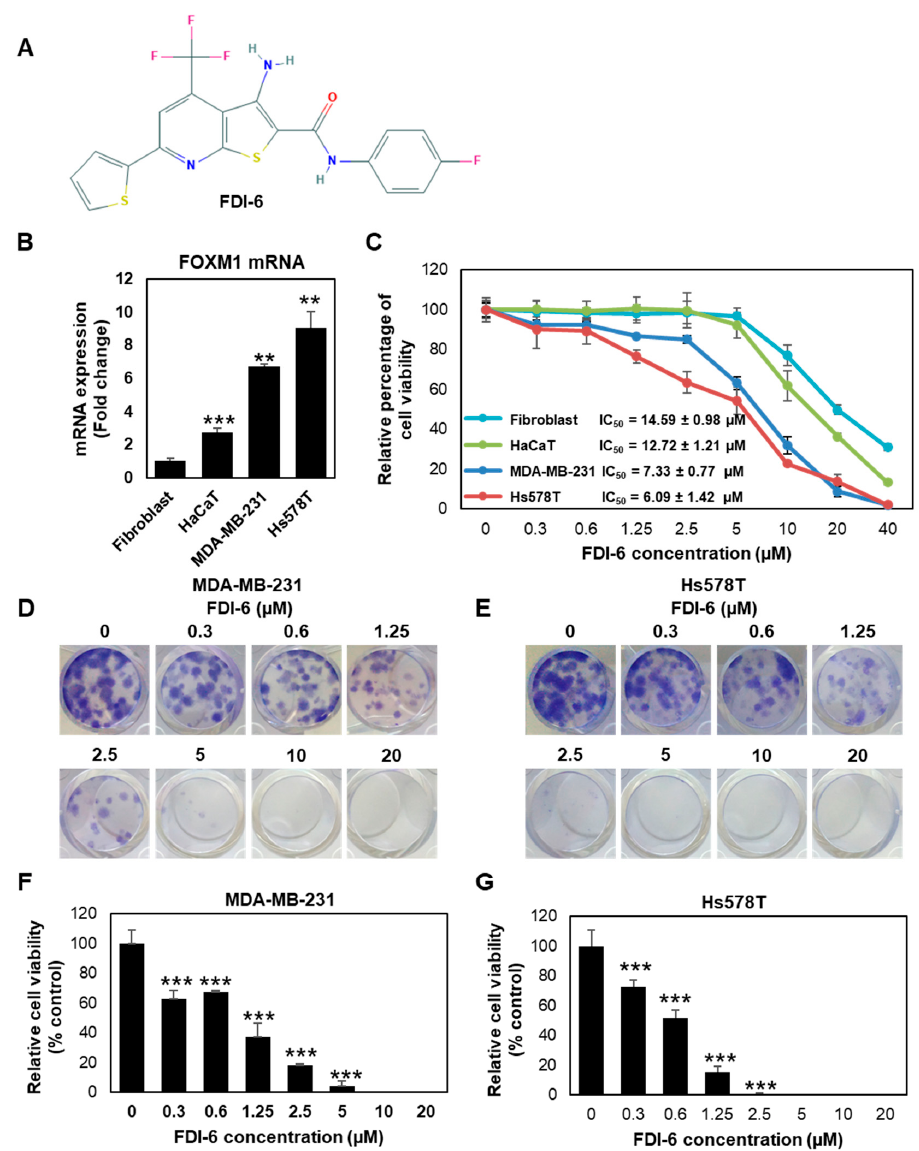
Figure 1. FDI-6 suppressed the proliferation of breast cancer. ( A ) Chemical structure of FDI-6 [18]; ( B ) mRNA expression level of FOXM1 in the cell lines used in this study determined by qRT-PCR after normalizing against L19 the house keeping gene; ( C ) SRB assay results of MDA-MB-231, Hs578T, fibroblasts, and HaCaT; ( D , E ) Colony formation images of ( D ) MDA-MB-231 and ( E ) Hs578T cells after being treated with different concentrations of FDI-6 for 72 h, and then incubated for 14 days; ( F , G ) Relative cell viability from the clonogenic assay of ( F ) MDA-MB-231 and ( G ) Hs578T cells in comparison with the control group. All bar graphs represent an average of three independent experiments ± S.D. ( n = 3). Statistical significance was determined by Student’s t -test (not significant, ns; significant, ** p < 0.01, *** p <